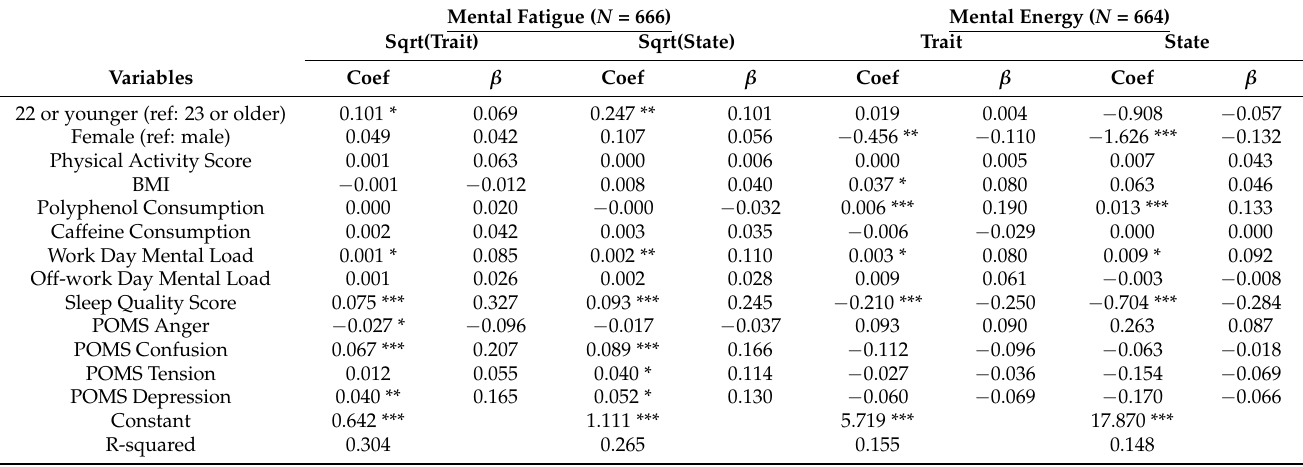
Table 2. Comparing predictors of trait and state mental energy and fatigue.